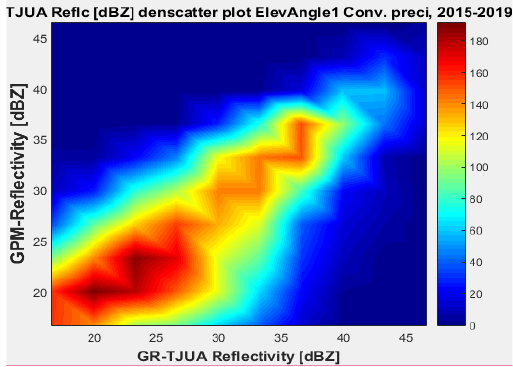
Figure 9. GPM ‐ Ka vs. NEXRAD TJUA for convective precipitation (angle 1).